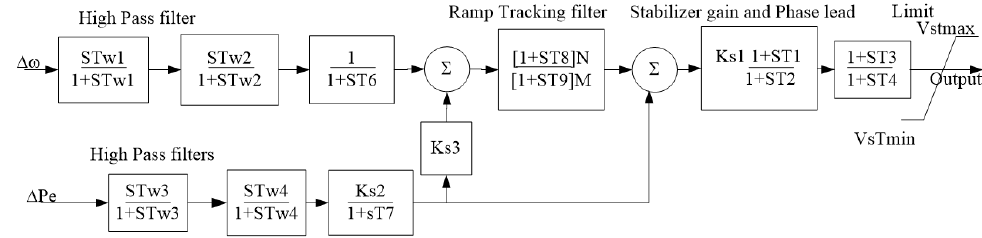
Figure 3. Dual-input power system stabilizer (PSS2B).